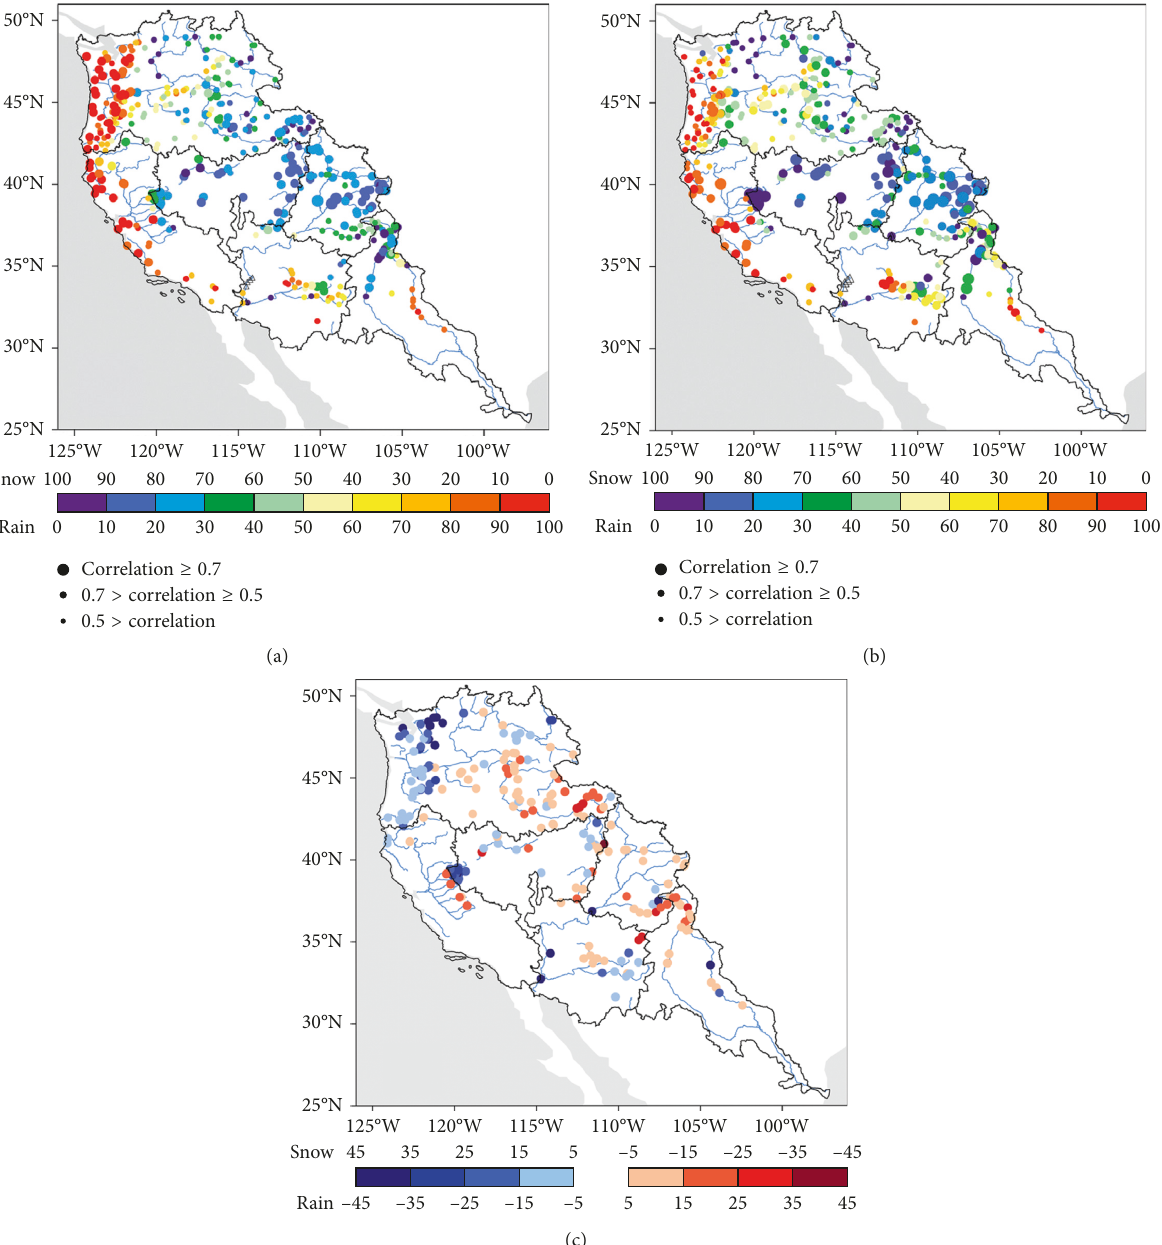
Figure 8: Distributions of the relative contributions of rainfall and snowfall to each streamflow station (unit: %): (a) annual contribution, (b) high-flow season contribution, and (c) difference between the high-flow season and annual contributions (i.e., high-flow season-annual). Hollow triangles represent stations that did not pass the 95% significance